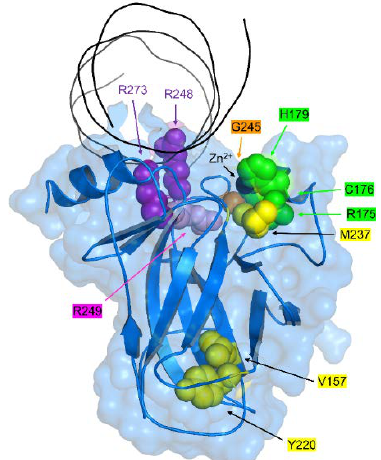
Figure 1. Locations of the top 10 most common somatic mutation sites in p53. The X-ray structure of wild-type (WT) DNA-binding domain (DBD) complexed to DNA is shown (PDB 1TSR). Mutational classes are colored as follows: DNA contact (purple), zinc binding (green), stability (yellow), mixed DNA-contact/stability (pink), and mixed zinc-binding/stability (orange). The zinc ion is the black sphere. Table 1. Top10 most common somatic p53 mutation sites in IARC Database R20. If multiple mutations at a single site are among the top 50 most common, they are listed in order of decreasing occurrence. DNA Zinc Stability Ref. Rank WT Mutants contact binding